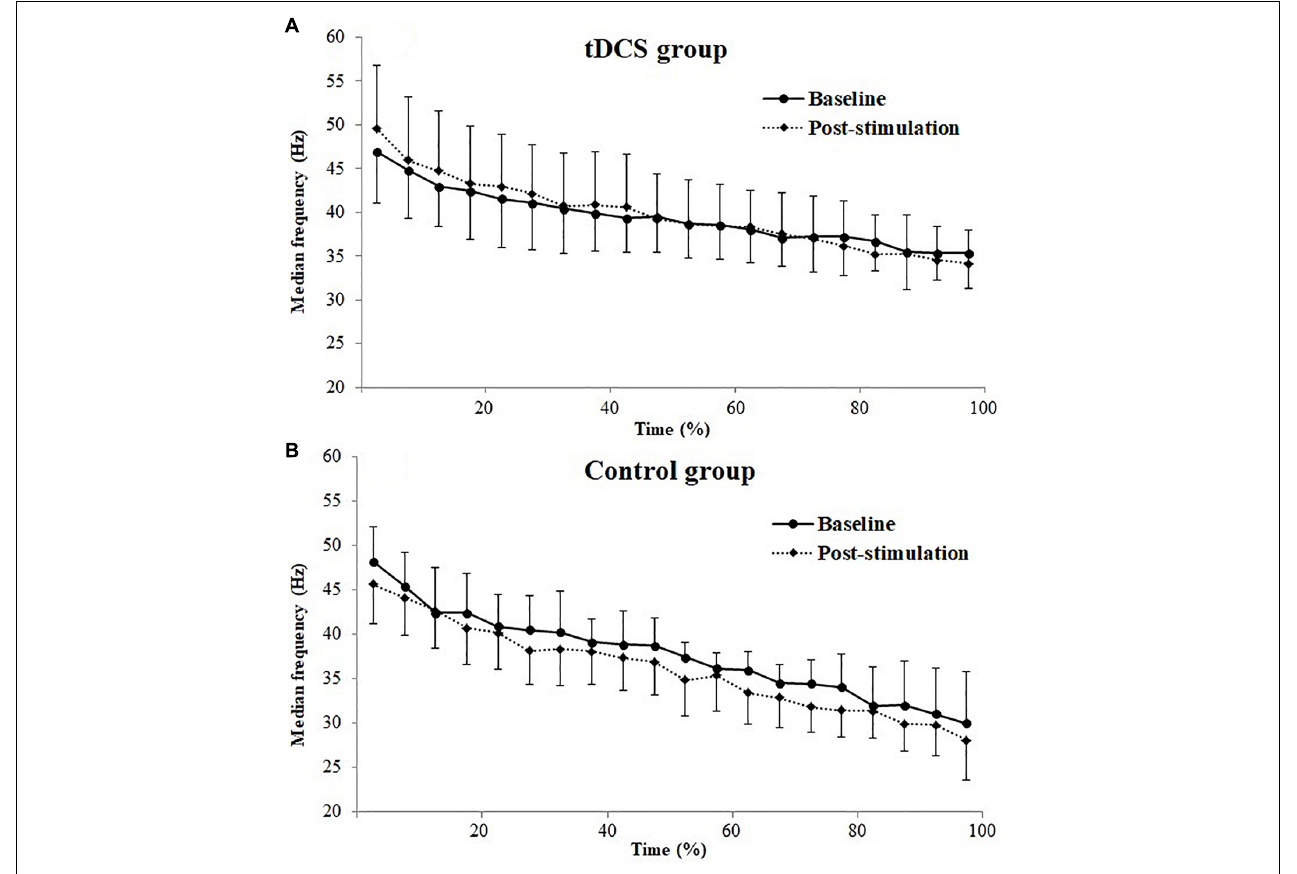
FIGURE 2 | Electromyography (EMG) median frequencies (mean ± SD) of biceps brachii (BB) muscle for transcranial direct current stimulation (tDCS, A ) and control (B) group subjects plotted as a percentage of contraction time during the sustained fatiguing elbow flexion contraction in baseline and post-stimulation